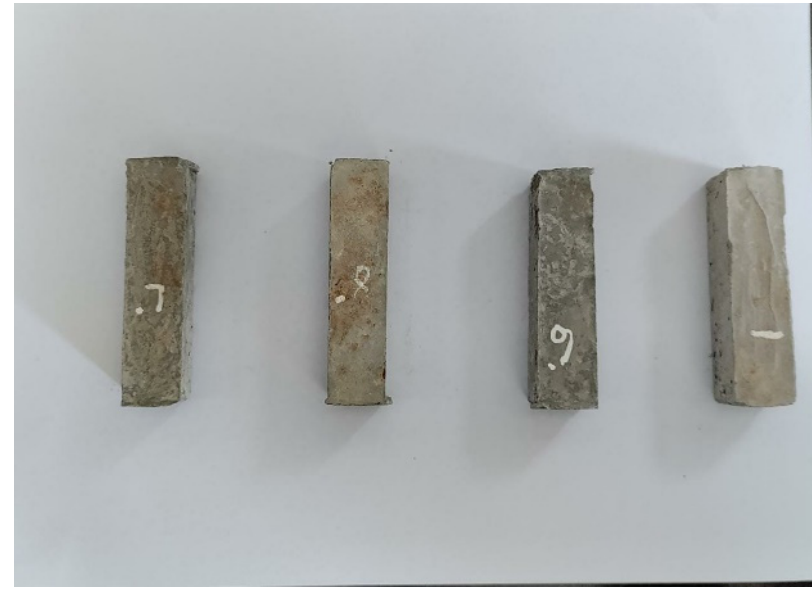
Figure 1. Samples